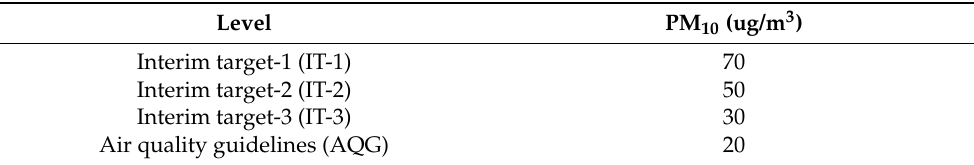
Table 5. Four annual mean concentration baseline levels of PM 10 .